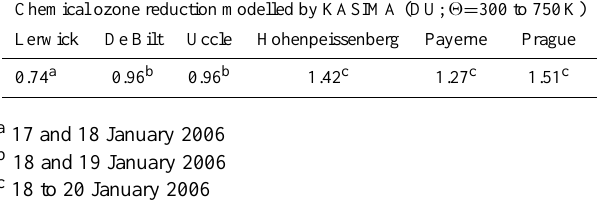
Table 6. Contribution in % of the influence of pressure changes on isentropes to the ozone column decrease within the layer 2 = 300 to 450K, for the six stations and the day of observed minimum of the total ozone column.